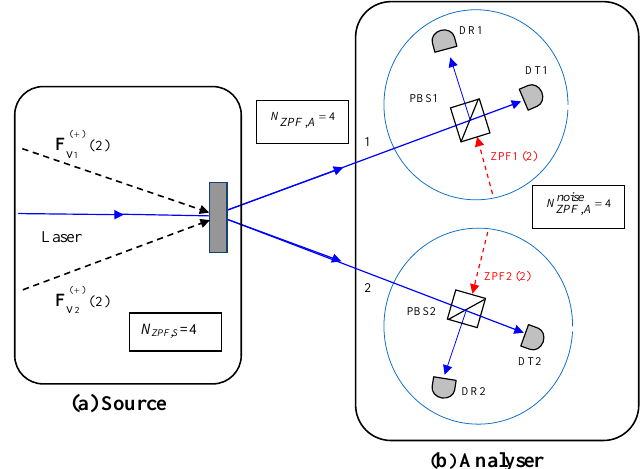
Figure 2. Zeropoint entries corresponding to a simple experiment on BSM. The number of relevant sets of vacuum modes are written between brackets. ( a ) Source . The beams concerning the inputs v1 and v2, each containing two sets of vacuum modes, interact with the laser field inside the crystal giving rise to the down-converted light (amplification of vacuum fluctuations). In this way, N ZPF , S = 4. ( b ) Analyser . It consists on two PBSs that transmit (reflect) horizontal (vertical) polarisation and four detectors. There are two zones for single detection, each consisting on one PBS and two